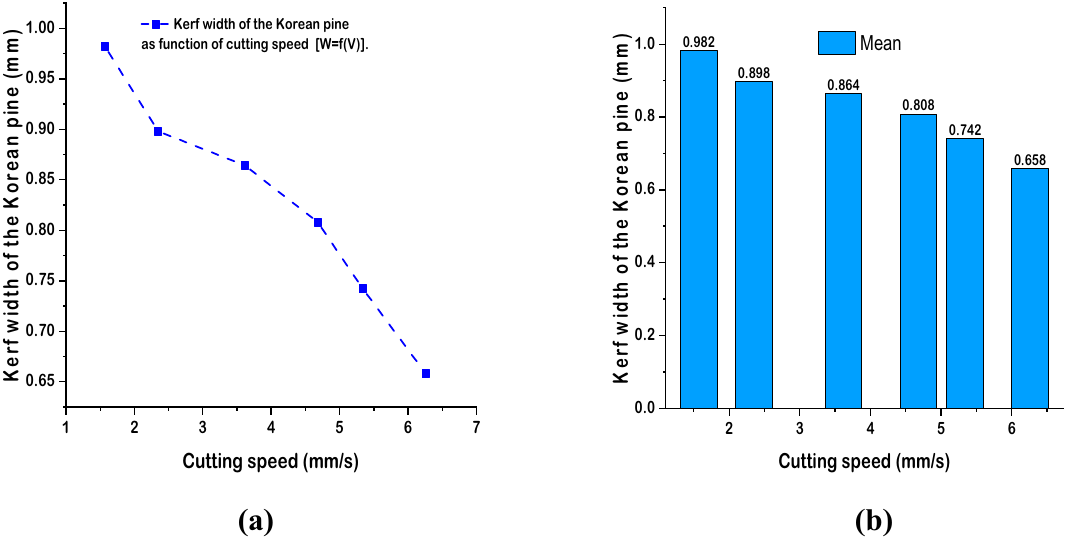
Fig. 14 Kerf width of Korean pine as a function of cutting speed [ W = f (V) ] a Kerf width variation of Korean pine, b Histogram of kerf width versus laser cutting speed